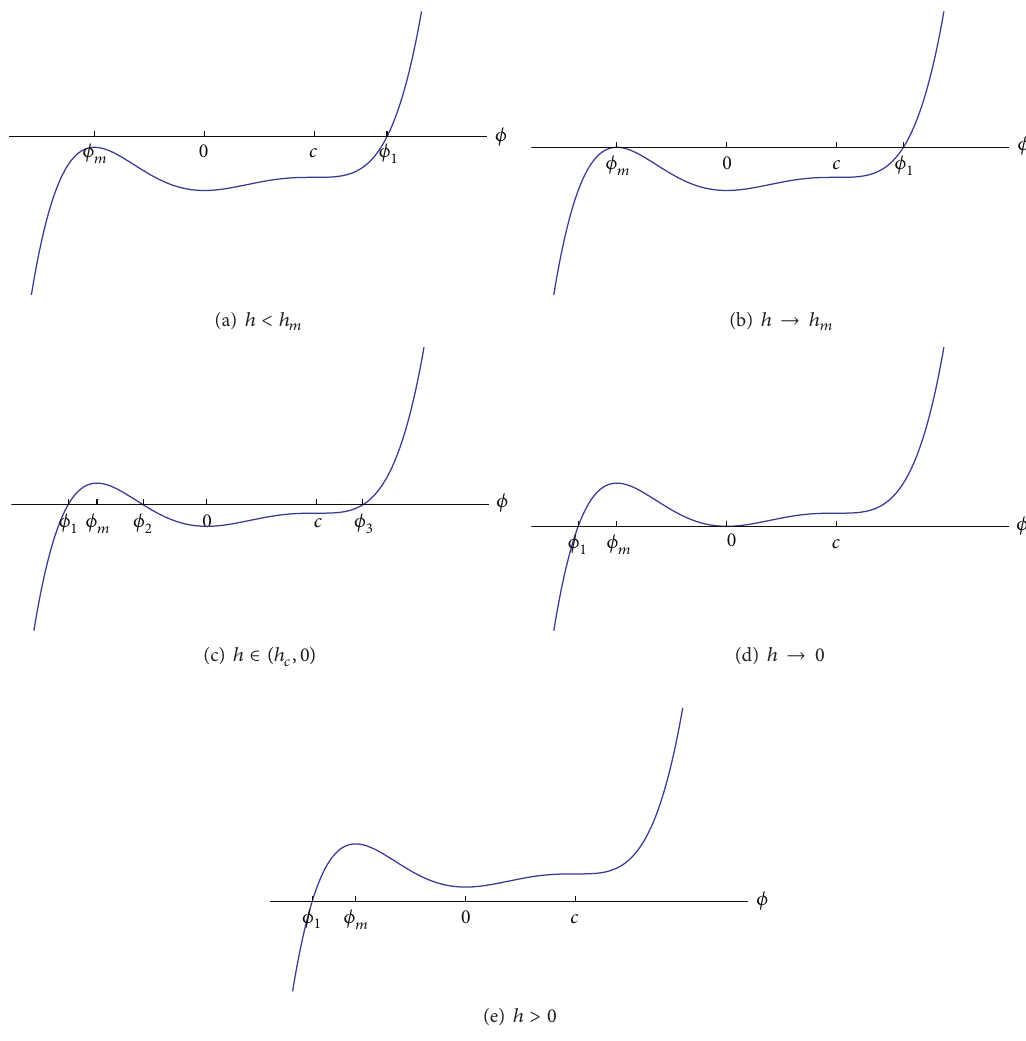
Figure 5: The graph of 𝐹(𝜙) as 𝑐 0 = (1/3)(3𝑐 − 4𝑐 2 )